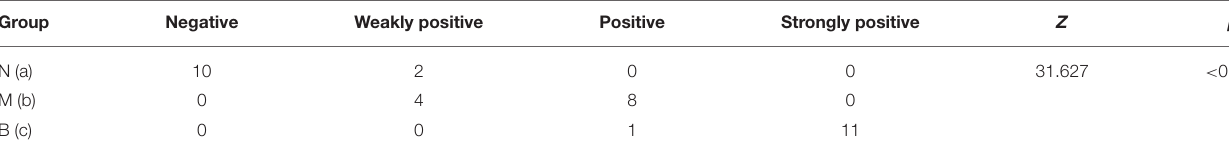
TABLE 2 | Comparison of IL-22 expression in three groups of mice epidermis. Group Negative Weakly positive Positive Strongly positive Z p 11 1 0 0 31.46 <